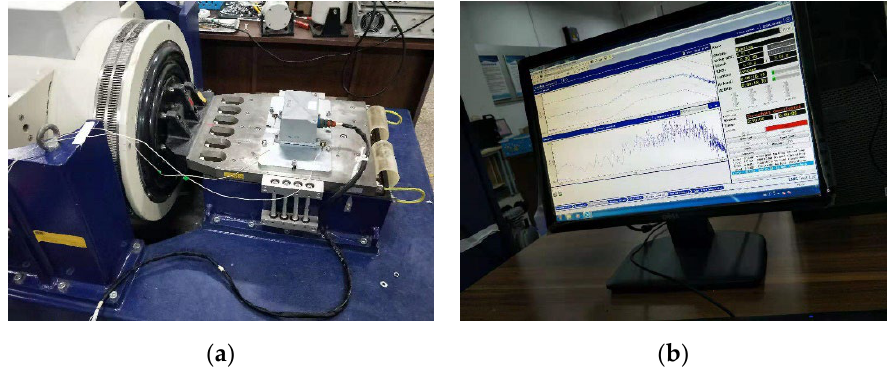
Figure 8. Experimental site and equipment: ( a ) experimental equipment; ( b ) Test Lab software.